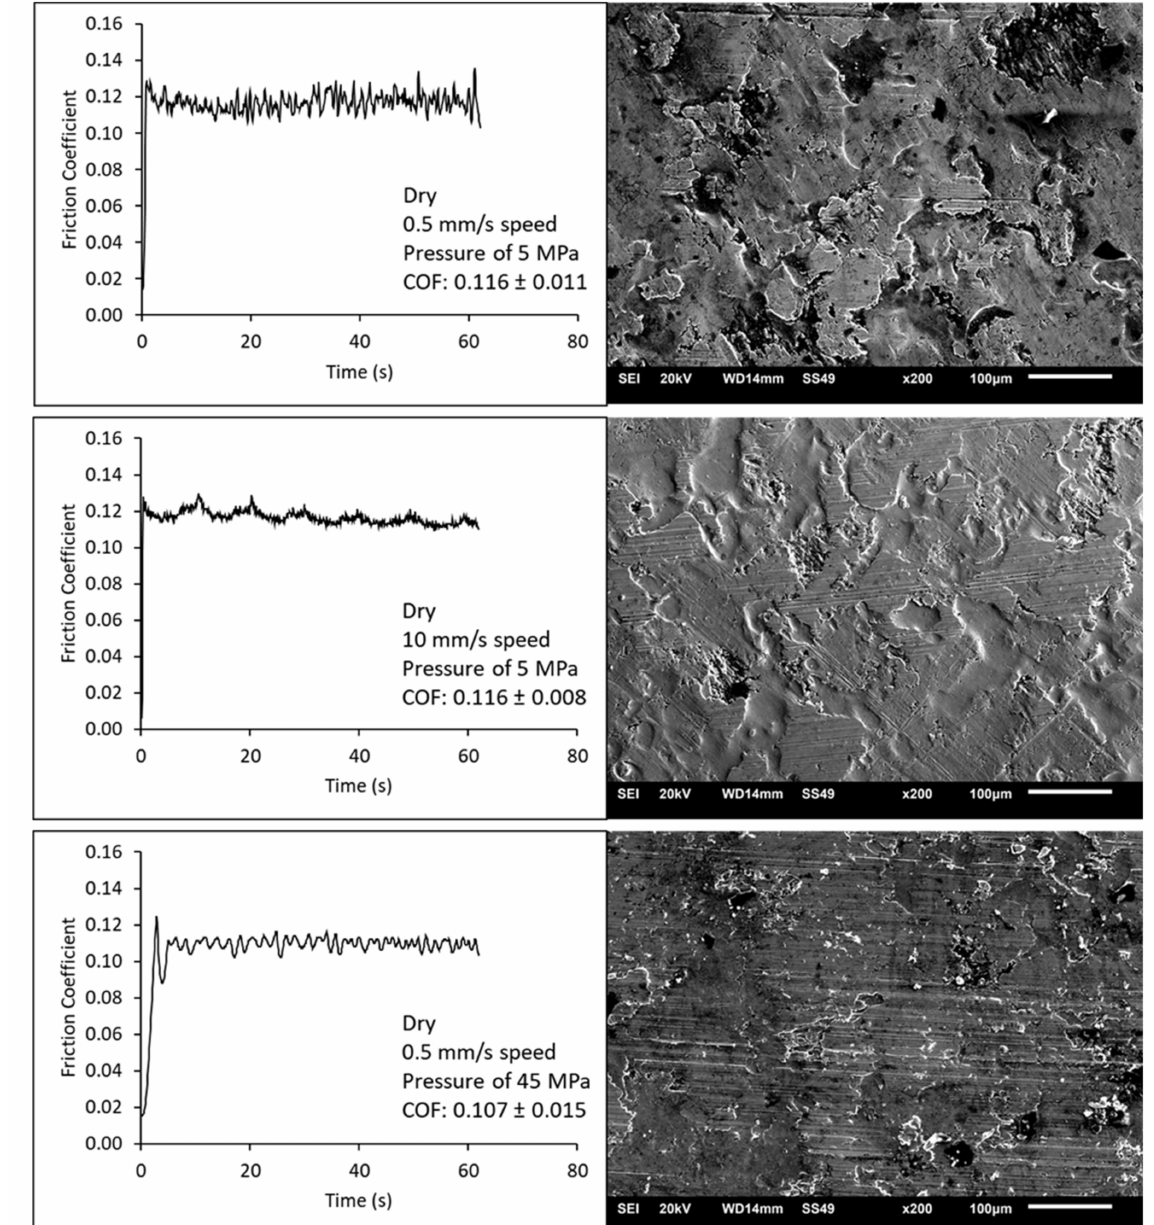
Figure 8. Measurement of coefficient of friction (COF) together with SEM analysis, for tests without lubricant, at room